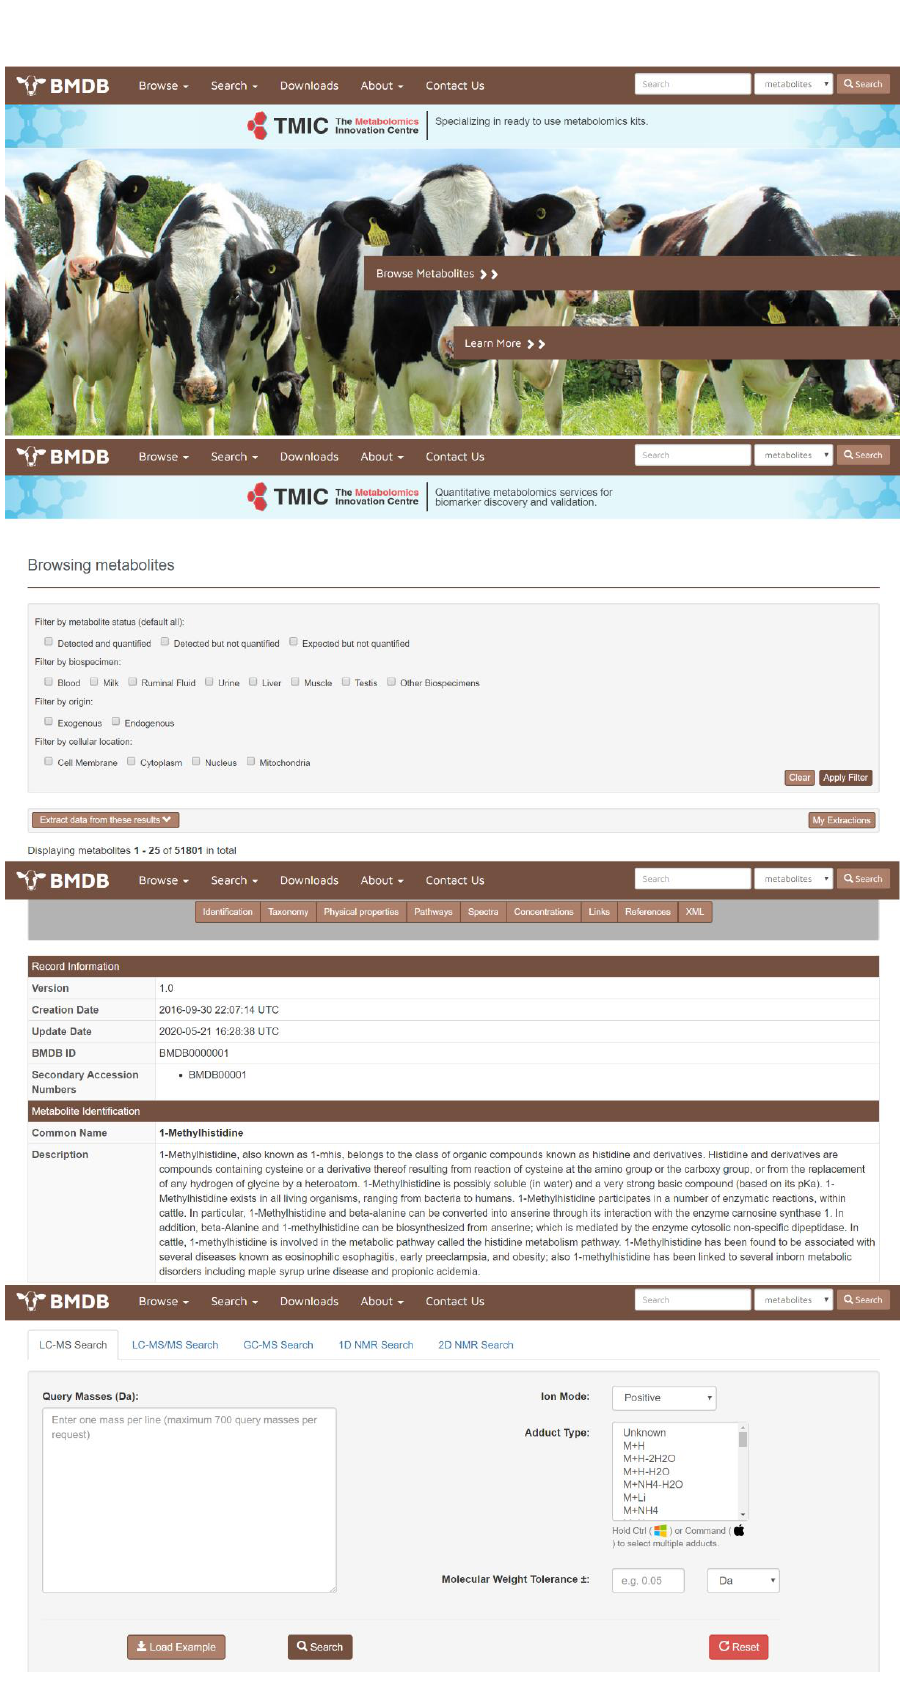
Figure 1. Screenshot montage of different browsing and searching screens taken from the Bovine Metabolome Database (BMDB). A more detailed description of the different functions and capabilities of the various browse and search tools in the BMDB is given in the text.